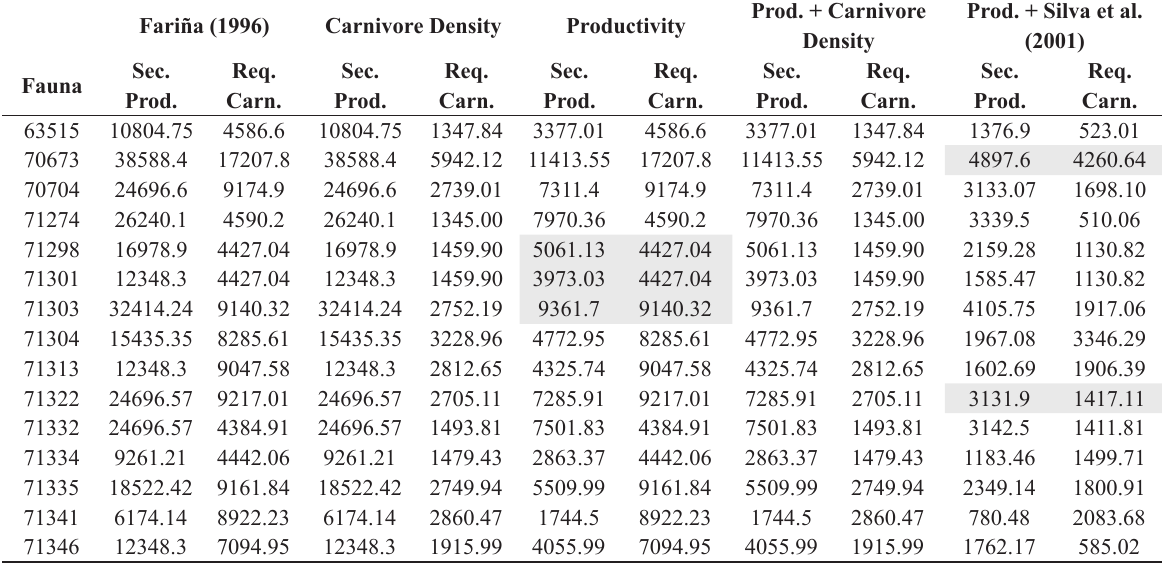
Secondary Productivity of the herbivores and requirements of the carnivores for South American faunas. Coloured cells indicate balanced